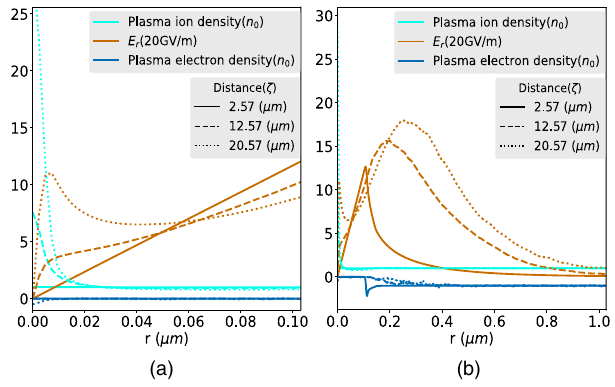
FIG. 3. The radial fields, plasma electron and ion densities inside the bubble cavity at three different ζ positions: (a) shows the region near axis in greater detail and (b) shows the longer range